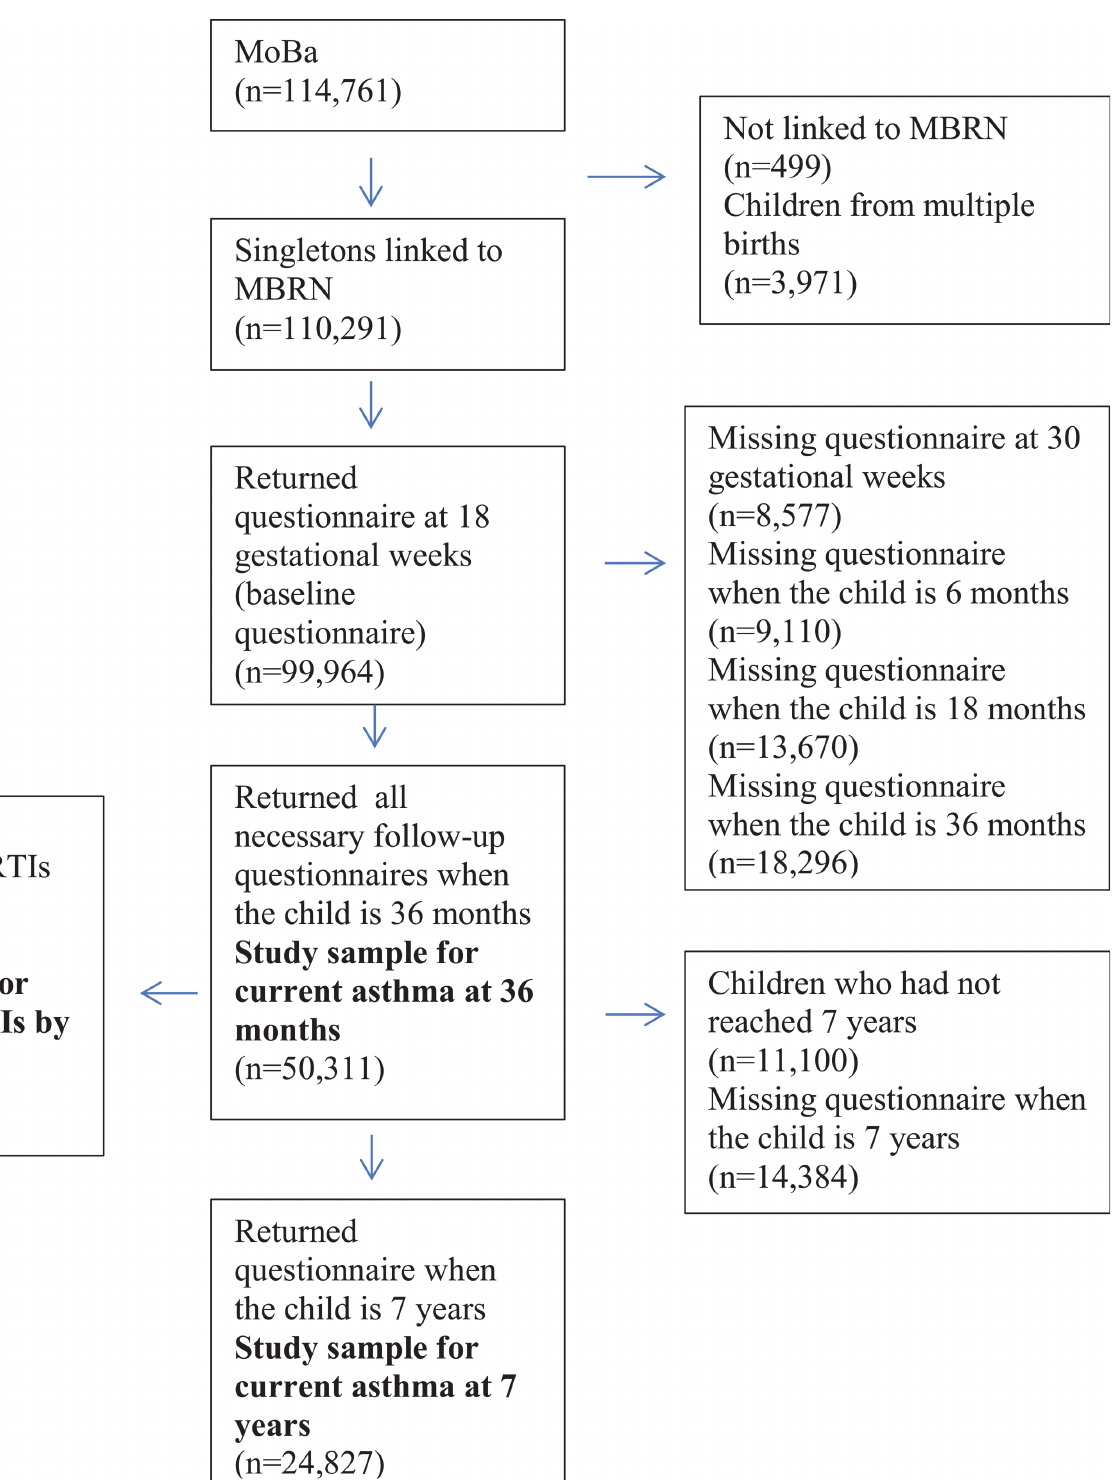
PLOS ONE | DOI:10.1371/journal.pone.0116362 January 30,